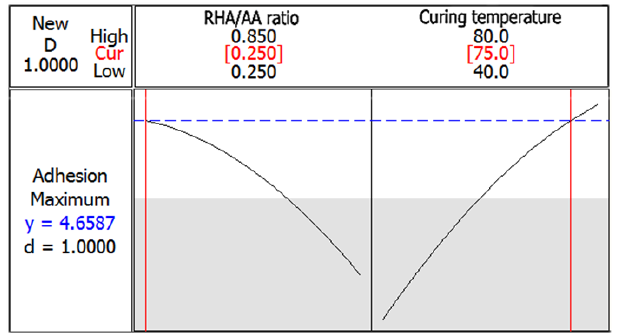
Figure 8. Optimization plot for adhesion strength.